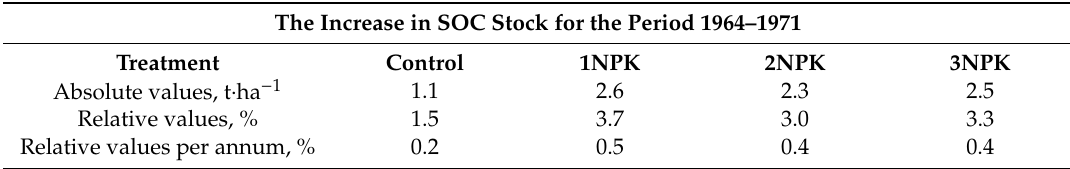
Table 5. The simulated increase in SOC stocks in the VNIISS experiment for the period 1964–1971. The Increase in SOC Stock for the Period 1964–1971